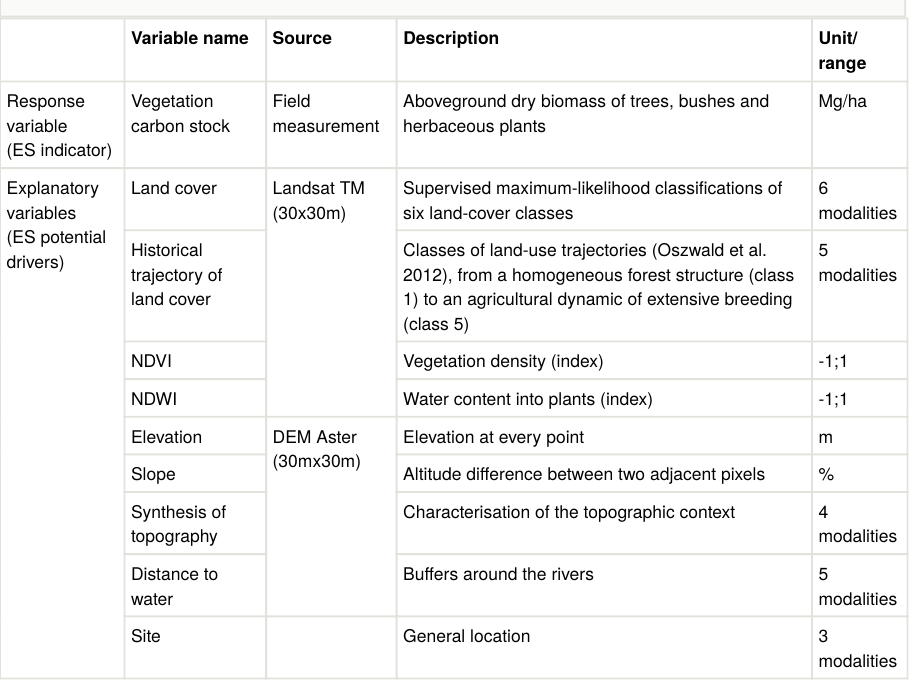
Table 1. Description of the data used in this study.The data constitutes the input of the statistical